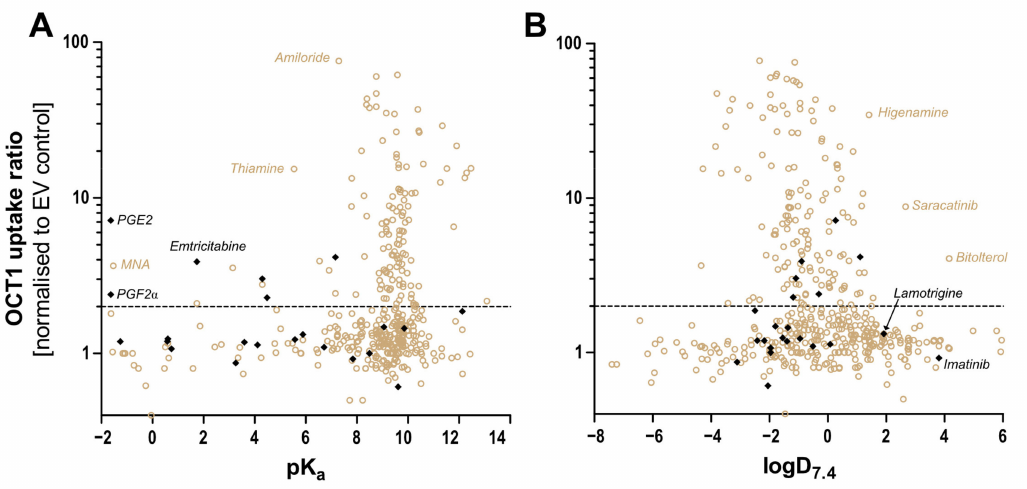
Figure 9. Correlation between the OCT1 uptake ratio and ( A ) pK a and ( B ) logD at pH 7.4. with ratio uptake data from here presented atypical substrates (black) and from published substrates (brown) [6–8,35]. An uptake ratio of 2 was also indicated earlier as the cut-off between substrates and non-substrates or irrelevant substrates. As illustrated, only very few substrates with a pK a below 6 are known thus far. Thiamine, with its high uptake ratio, is an exception from that rule, as is prostaglandin E2. Concerning lipophilicity, at present, there are only two substrates with a logD 7.4 above 2 and a relevant OCT1 transport